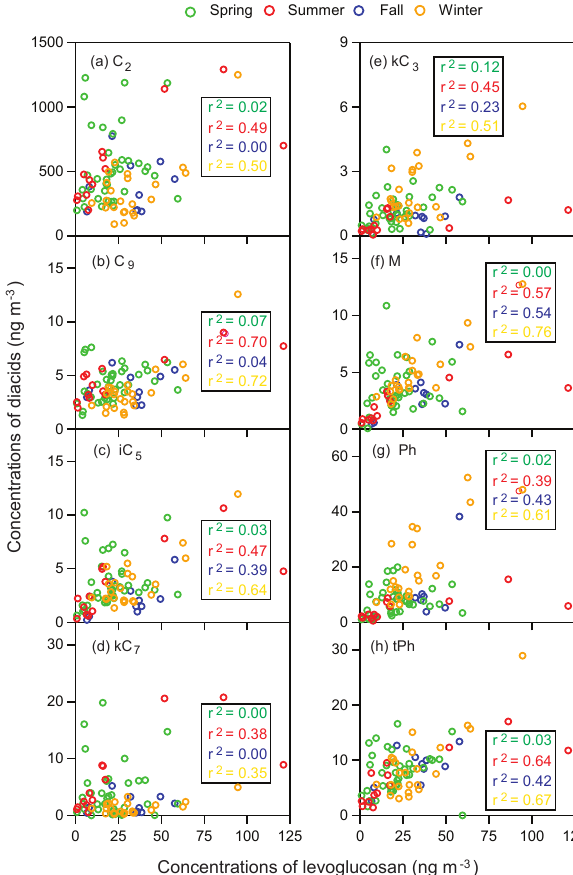
Figure 8. Boxplots depicting the interannual (2001–2008) trends in major saturated (a – f) and unsaturated (g – h) diacids in April: (a) oxalic (C 2 ) , (b) malonic (C 3 ) , (c) succinic (C 4 ) , (d) adipic (C 6 ) , (e) azelaic acid (C 9 ) , (f) methylsuccinic (iC 5 ) , (g) isophthalic (iPh), and (h) phthalic (Ph) acids. The trends in interannual variations for the other months are shown in Table S1. The lower, middle, and up- per lines in the box represent the 25th, 50th and 75th percentiles, respectively. The lower and upper whiskers represent the 10th and 90th percentiles, respectively. The r 2 values were calculated based on the median concentrations using a linear regression